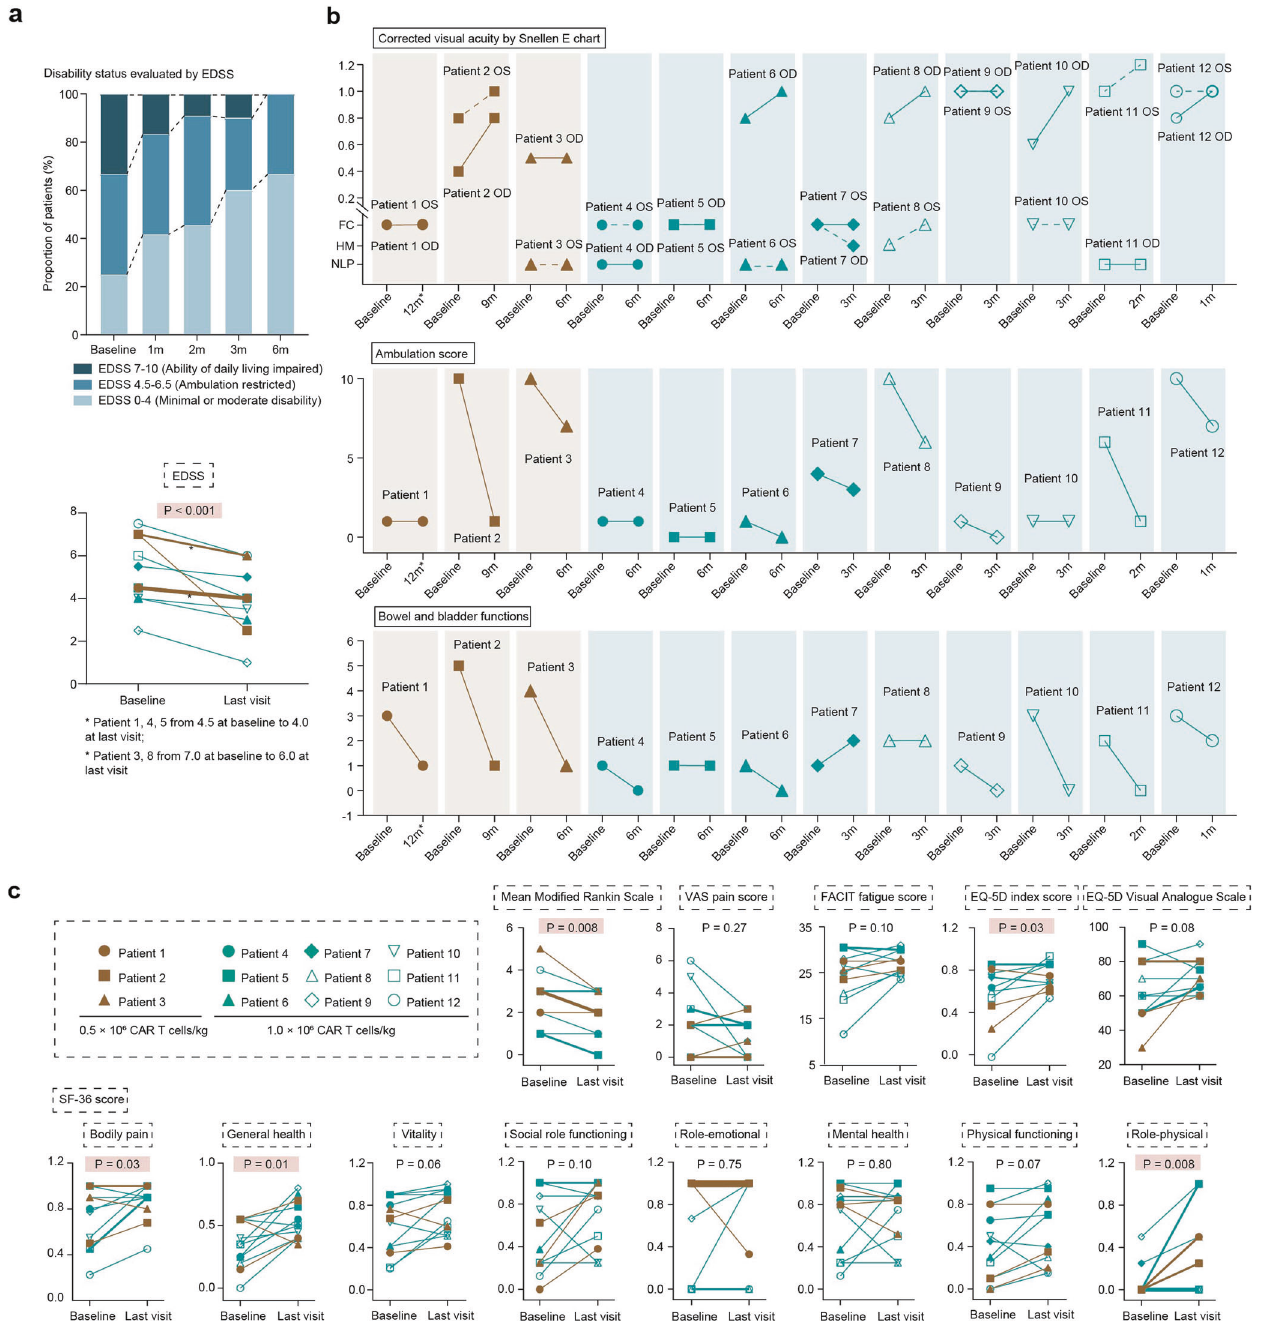
Fig. 4 Functional improvement after CT103A infusion. a Distribution of EDSS score at baseline and post infusion. EDSS were shown individually at baseline and last visit. b Individual values of corrected visual acuity by Snellen E chart, functional system score from the Expanded Disability Status Scale in ambulation (scored from 0 [Unrestricted] to 12 [essentially restricted to bed or chair or perambulated in wheelchair]), and bowel and bladder functions (scored from 0 [no symptoms] to 6 [loss of bowel and bladder function]) at baseline and last visit. Solid and dotted lines represent changes of corrected visual acuity in oculus dexter (OD) and oculus sinister (OS), respectively. c Individual values of disability and quality-of-life outcomes. Secondary endpoints for disability and quality-of-life outcomes were evaluated, including the modi fi ed Rankin scale (scored from 0 [no symptoms] to 6 [death]); the Expanded Disability Status Scale (EDSS, range from 0 [normal neurologic examination] to 10 [death]), visual analog scale (VAS) score for pain (on a scale from 0 to 100, with higher scores indicating more pain); the Functional Assessment of Chronic Illness Therapy – Fatigue (FACIT-F) score (on a scale from 0 to 52, with higher scores indicating less fatigue); the EuroQol-5 Dimensions (EQ-5D) instrument (scored on a scale from − 0.109 to 1, with higher scores indicating a better health state); EQ-5D-VAS (on a scale from 0 to 100, with higher scores indicating better condition); the 36-item Short Form Health Survey (SF-36; eight sections with scores transformed to 0 to 1, with lower scores indicating greater disability). Data were shown individually at baseline and last visit. Data with same values were displayed overlapped. Comparison was performed by Wilcoxon-matched-pair-signed rank